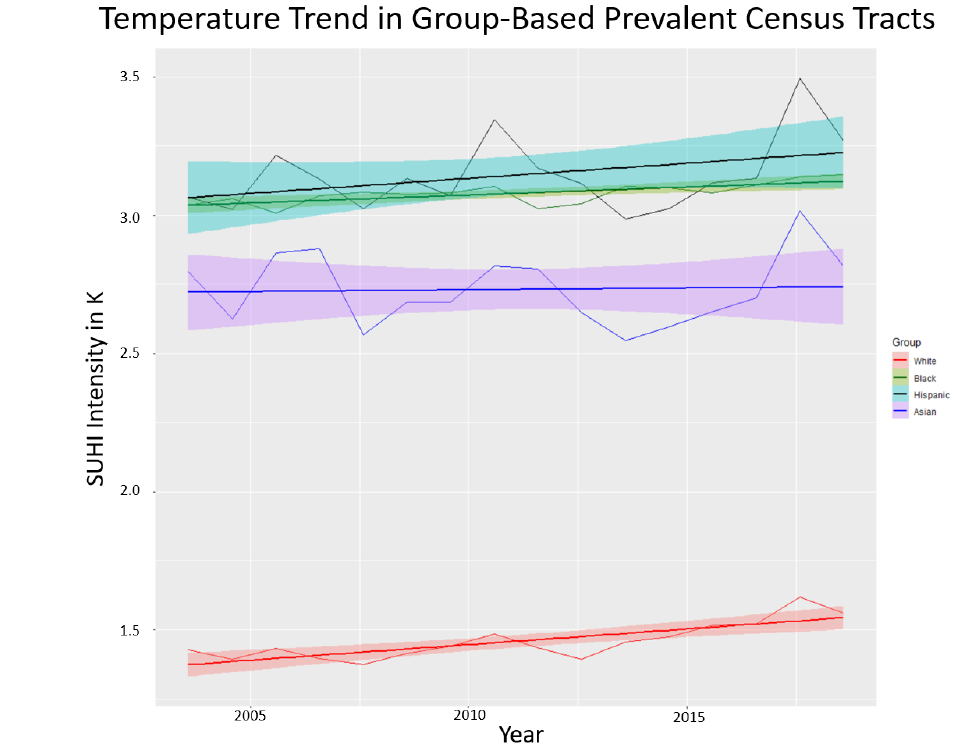
Figure 3. Daytime SUHI intensity for prevalent tracts of each demographic group through time. These are the observed raw (non-modeled) values averaged yearly for census tracts classified by prevalence of each demographic group from 2003 to 2018. The line of best fit and confidence intervals are determined by univariate ordinary least squares linear regression.